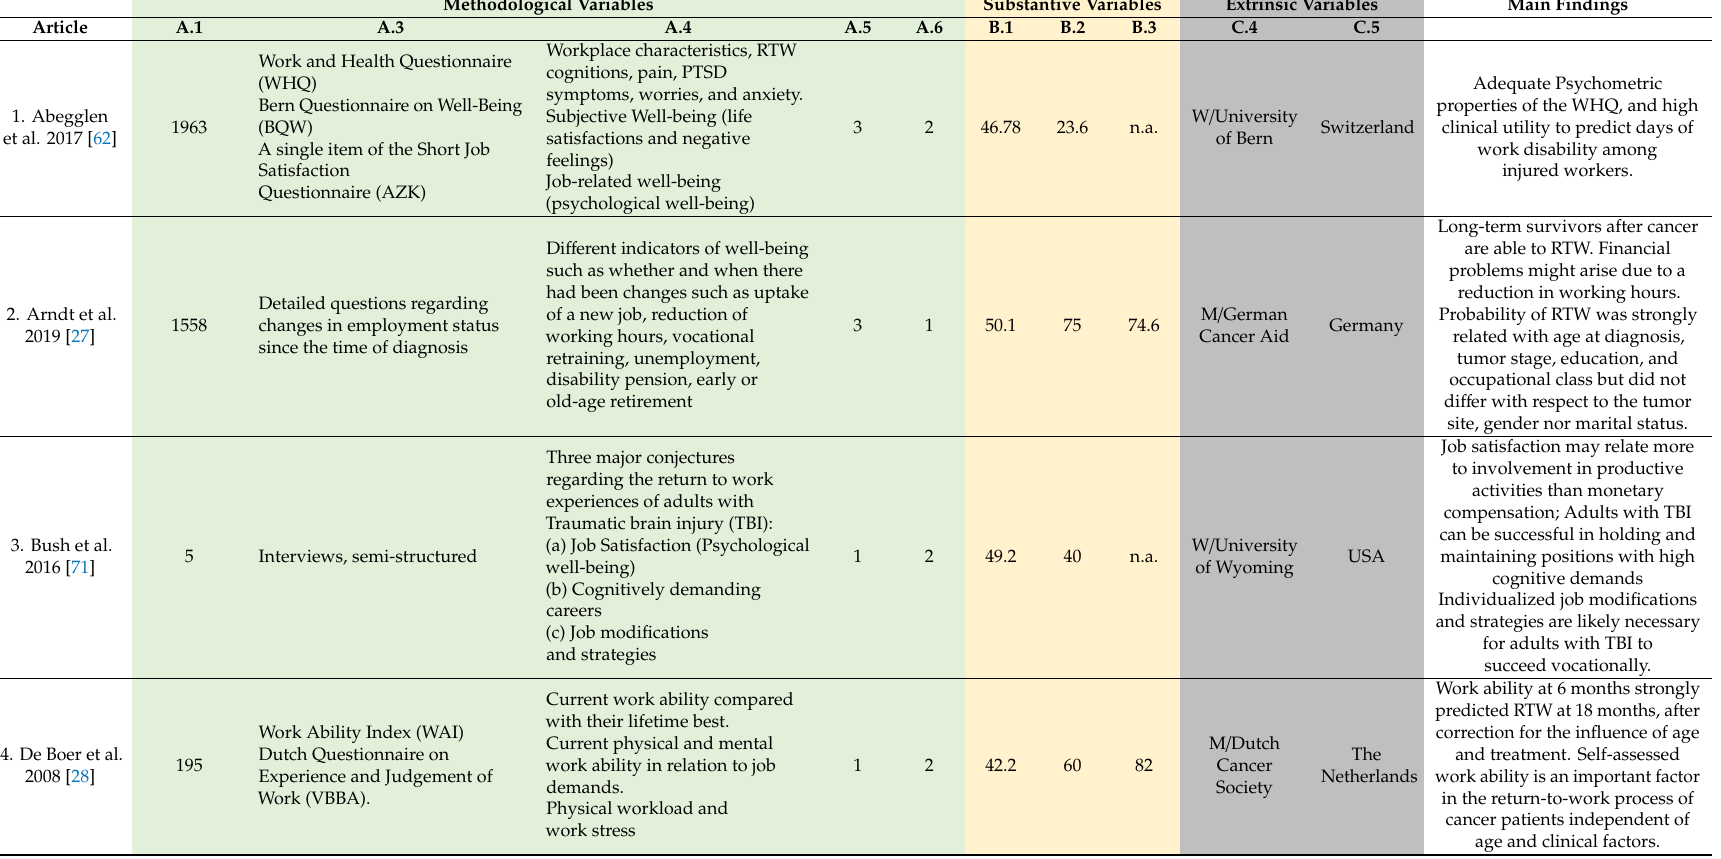
Table 1. Studies included in the